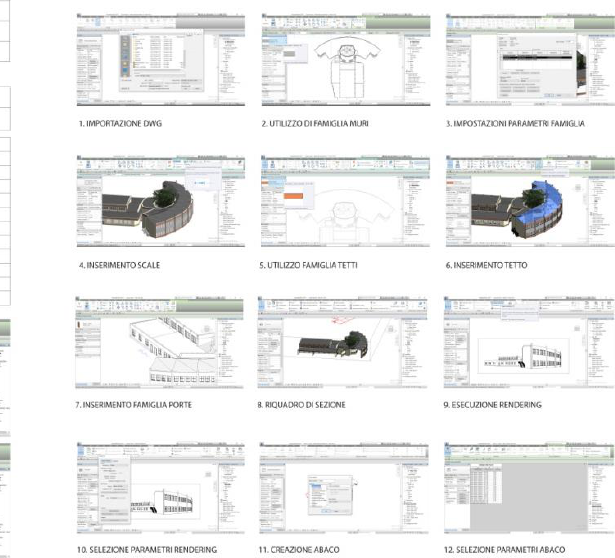
Figure 15. (A) Revit script data abacus of elements.